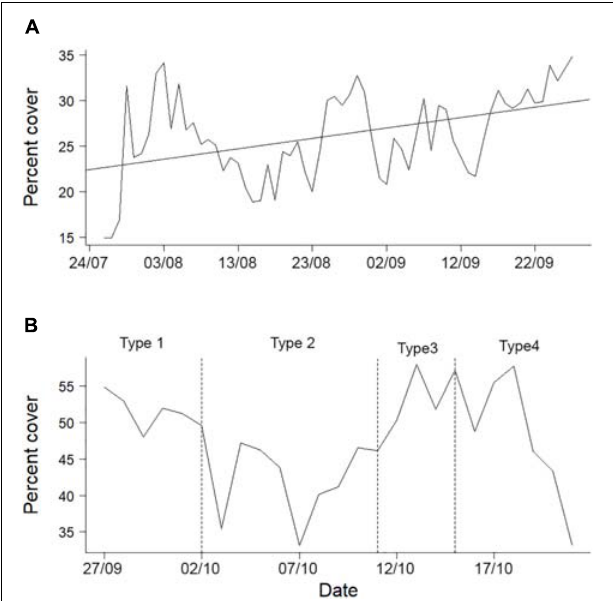
FIGURE 4 | Changes in the percentage of microbial mat cover (A) before and (B) after the mud eruption. While five different field of view categories were identified after the eruption, only images from field of view categories 1 to 4 were analyzed (type 5 images were not analyzed because of the very limited field of view: ≤ 0.2 m 2